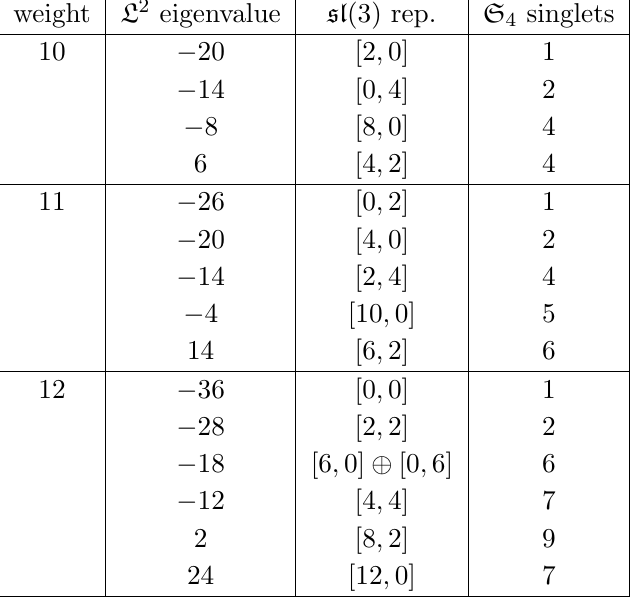
Table 2 . Eigenvalues and degeneracies of the modular Laplacian acting on tetrahedral modular graph functions of weights 10, 11 and